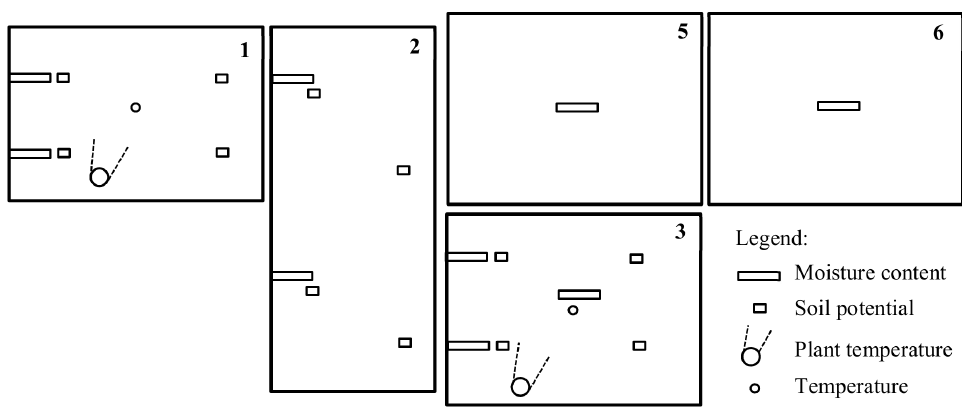
Figure 3. Position of sensors in test samples (external view on test samples – since